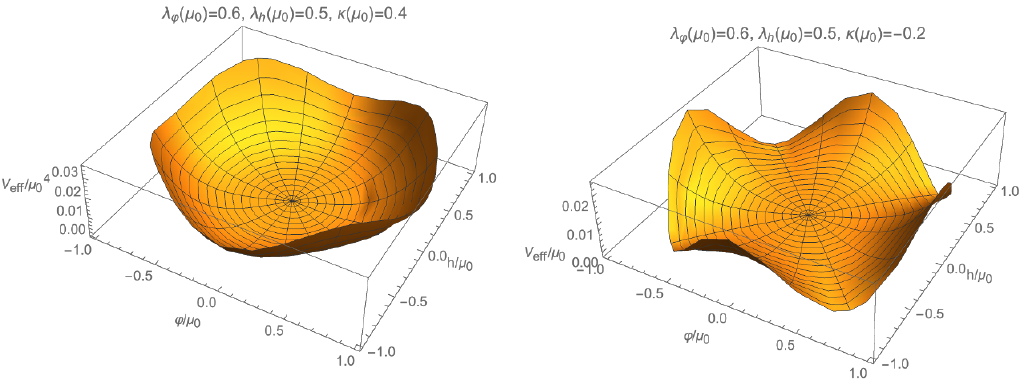
Figure 6 . Improved one-loop e(cid:11)ective potentials of two real scalar model. The left (right) (cid:12)gure corresponds to the (cid:20) > 0 ( < 0)